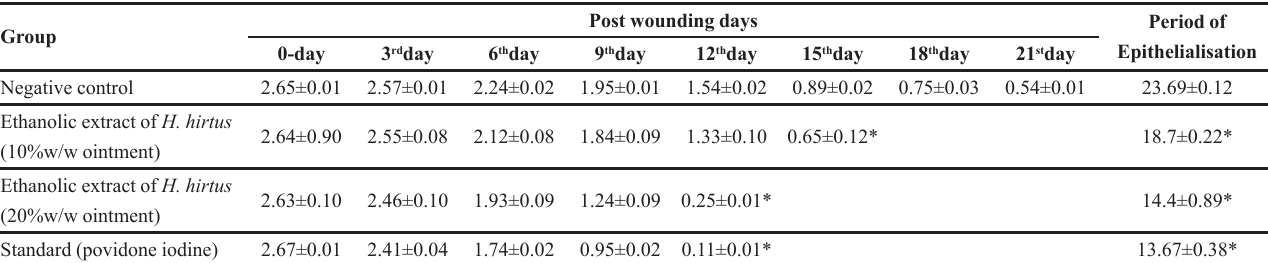
TABLE IV - Effect of topical application of ethanolic extract of Hibiscus hirtus by using oleaginous ointment base for healing of